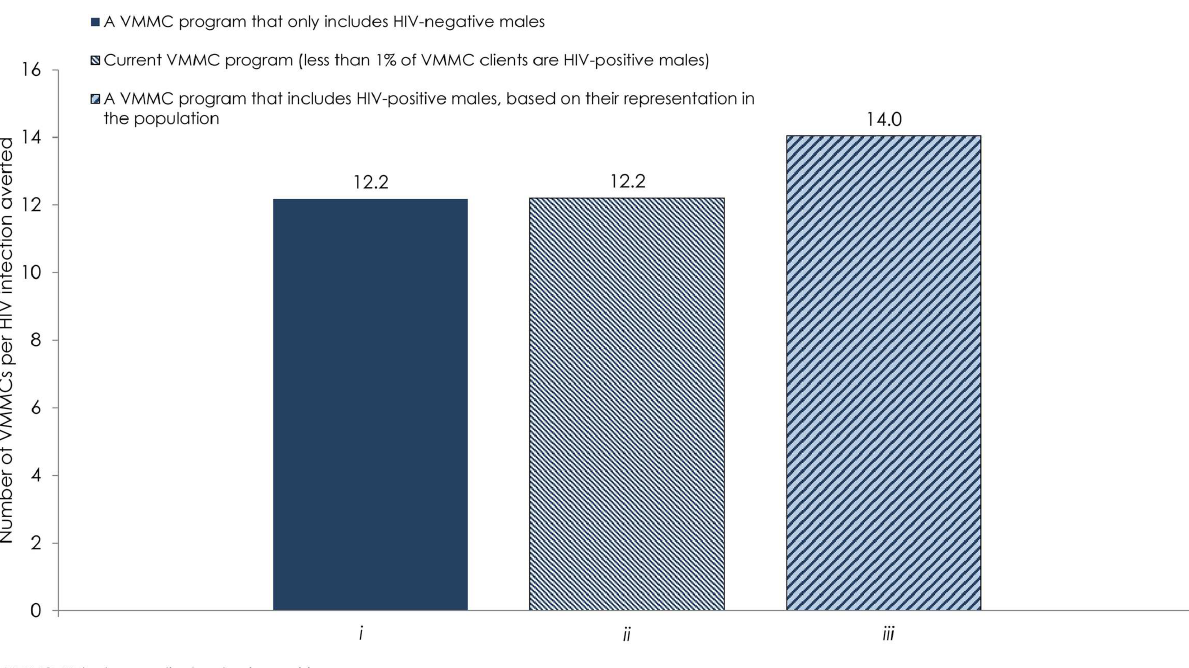
Fig 2. Impact of excluding or including HIV-positive males in the VMMC program in Zambia. The figure shows the effectiveness of the VMMC program including i ) only HIV-negative males, ii ) HIV-positive males as per current program data, and iii ) proportionof HIV-positive males, basedon their representation in the population.No efficacy of male circumcisionagainstmale-to-female HIV transmissionwas assumed. Effectiveness is definedas the number of VMMCs neededto avert one HIV